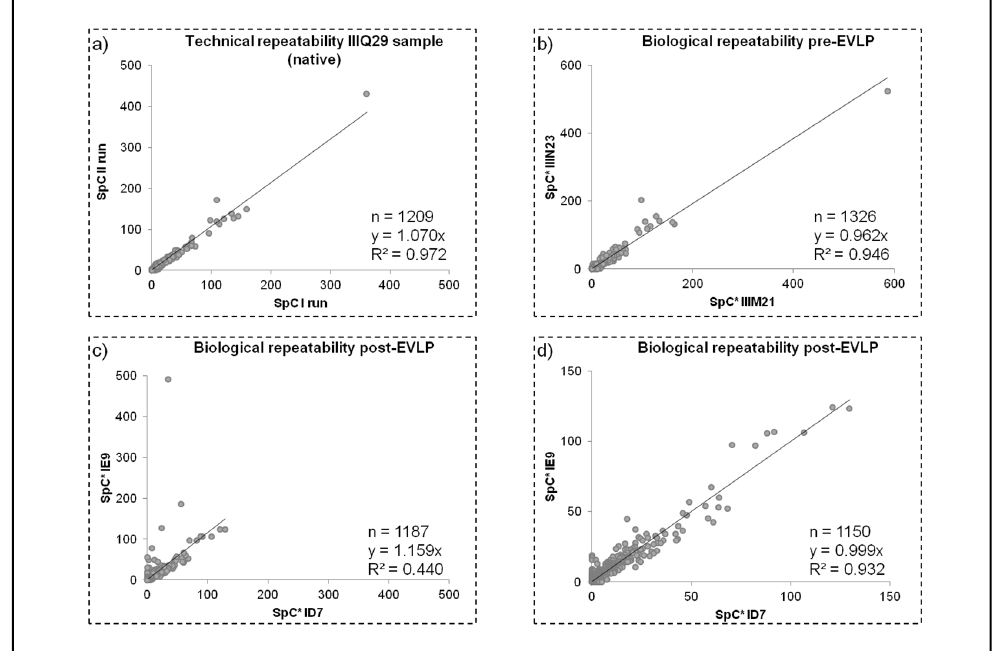
Figure 4. Examples of technical and biological repeatability of proteomic analysis. ( a ) Typical technical repeatability (IIIQ29 sample, native group). ( b ) Biological repeatability between two native samples (IIIM21 and IIIN23). ( c ) Biological repeatability of IE9 sample compared to ID7 (post-EVLP samples). ( d ) Biological repeatability of IE9 sample compared to ID7 without the scattered proteins (mainly plasma proteins). SpC*: Average spectral count value.